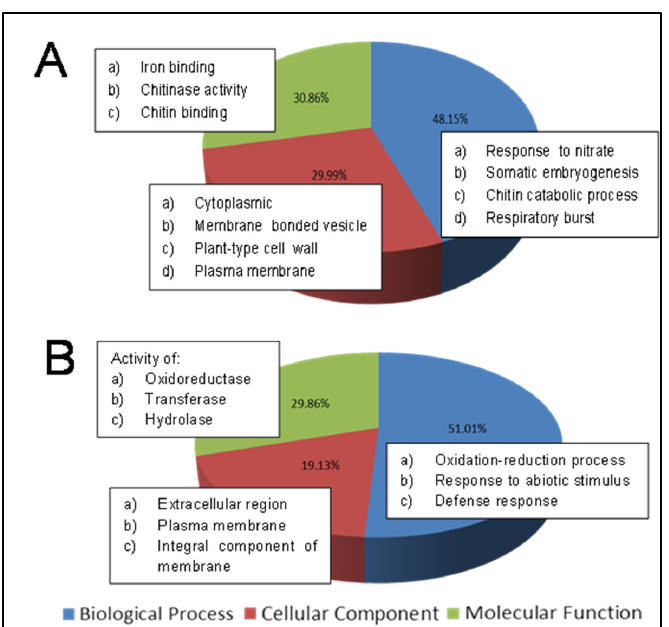
Figure 1. Gene Ontology (GO) clustering analysis for both root treatments. GO characterized the DEGs into biological processes, molecular functions and cellular components. ( A ) Root early infection genes (REI/REC) and ( B ) root late infection genes (RLI/RLC).